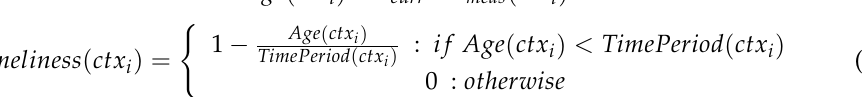
Figure 7. A geohash 9q9p6, with several more precise geohashes contained within it. After performing a search using the location data, the found data is evaluated with the QoC parameters described below. These parameters were used to verify the validity of context information over time, that is, to verify that the data did not expire according to the